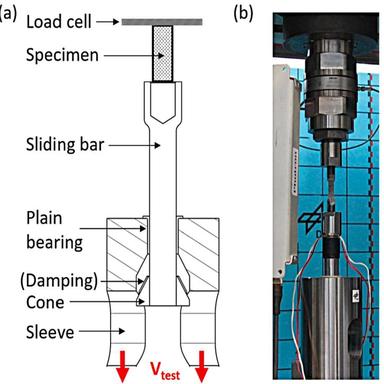
The developed slack adapter: (a) cross-sectional representation; (b) placed within the high-speed servo-hydraulic test set-up.